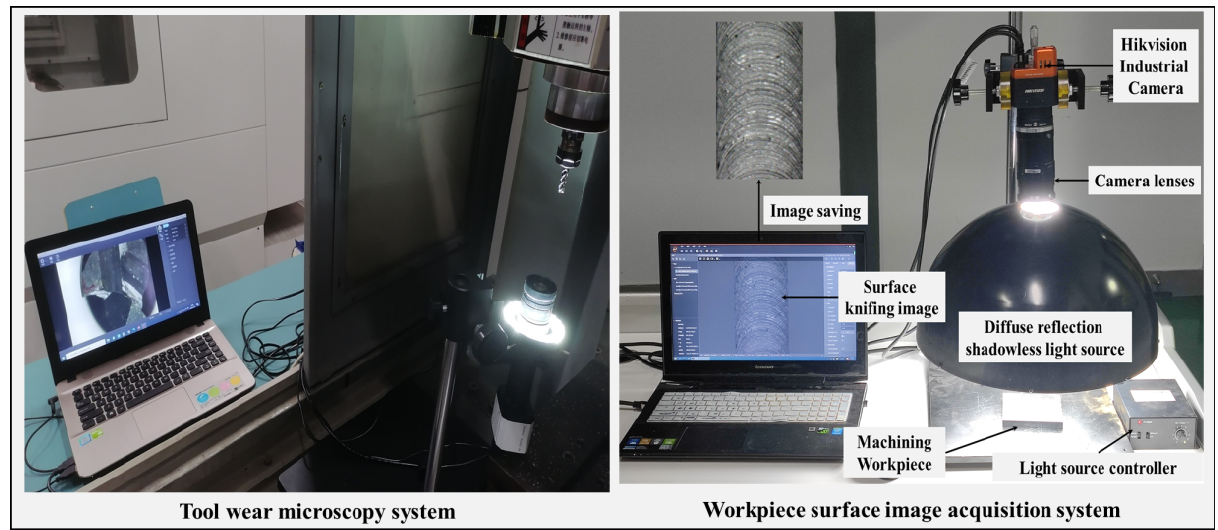
Figure 9. Tool wear measurement system and surface image acquisition